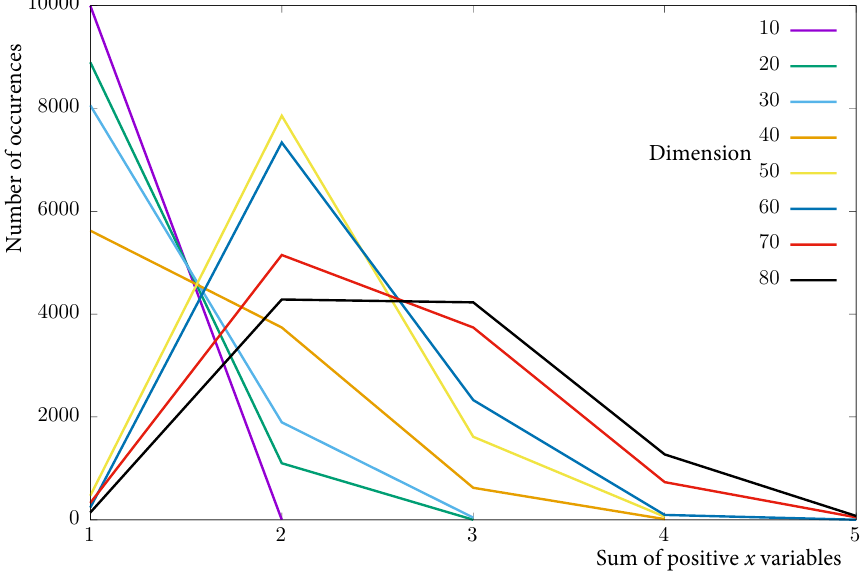
Figure 18. In this figure one can see how the dimension of x affects the accuracy of the embedding of the constraint, i.e., the number of + 1 s in the resulting